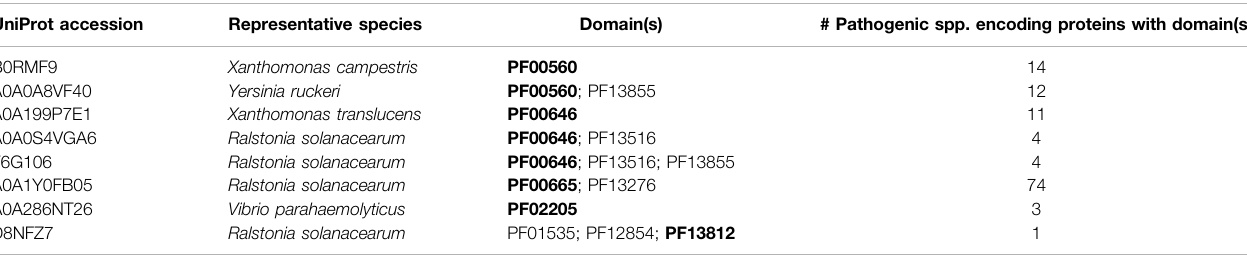
TABLE 1 | Effectors containing domains that mediate PPIs exclusively in eukaryotes.